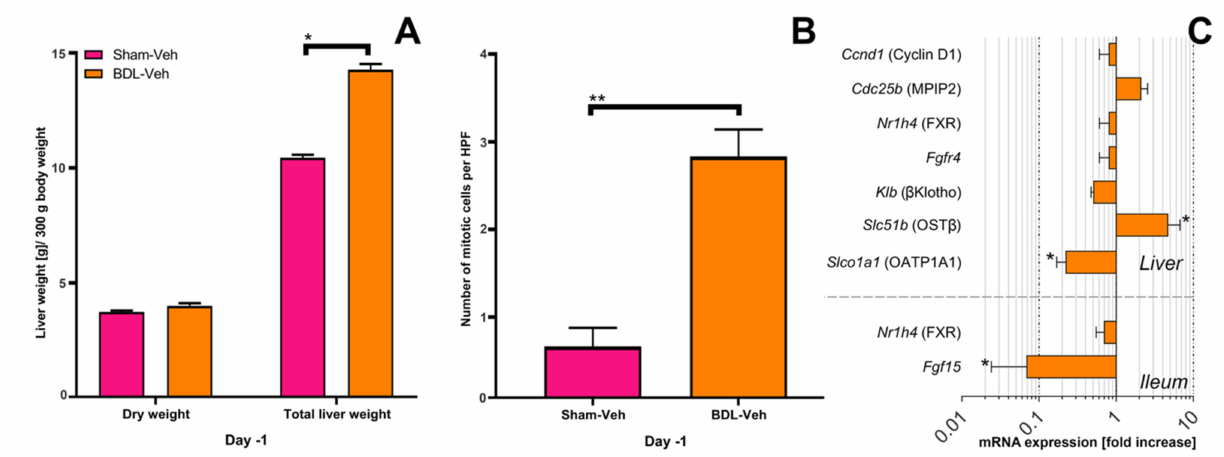
Figure 3. Obstructive cholestasis does not induce proliferation prior to partial resection. ( A ) Dry liver weight and total (wet) liver weight 1 day before PHx ( t = − 1 day) expressed in g per 300 g body weight. ( B ) Number of mitotic cells per high-power field (HPF) in the area with the highest mitotic activity 1 day before PHx ( t = − 1 day). ( C ) mRNA expression levels in liver and ileum in the BDL group 6 days after BDL and 1 day before PHx ( t = − 1 day) expressed as fold-increase relative to the Sham group on t = − 1 day. Significance was assessed using a Mann–Whitney U test. * indicates p < 0.05. Veh, vehicle; BDL, bile duct